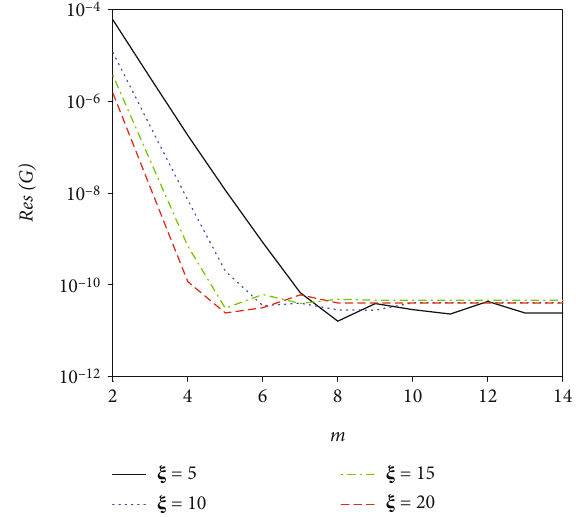
Figure 22: Variation of residual error Res ð G Þ against increasing order ð m Þ of LSPM series approximation for di ff erent values the non-similar parameter ξ , when n = 0 : 5, K = 0 : 5, Pr = 10, S = 3, N